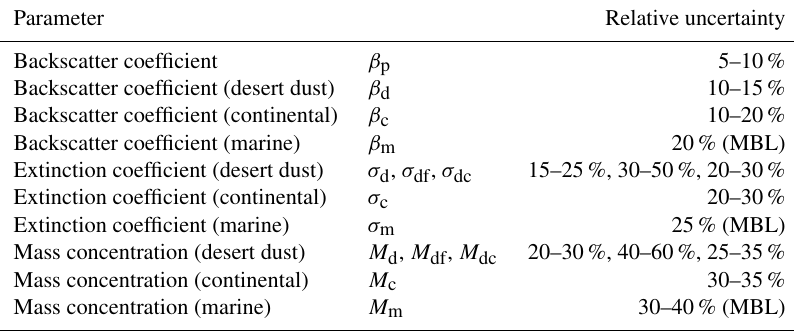
Table 4. Typical uncertainties in the lidar-derived particle optical properties (for 532nm wavelength), and volume and mass concentrations. MBL stands for marine boundary